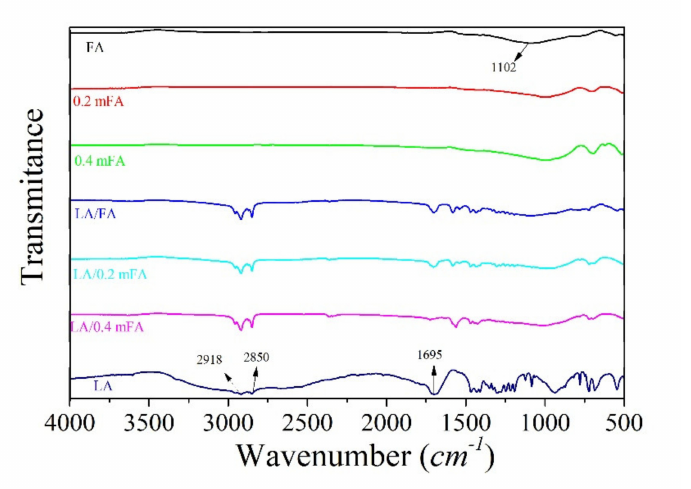
Figure 6. FT-IR spectra of FA, 0.2 mFA, 0.4 mFA, LA/0.2 mFA, LA/0.4 mFA, and